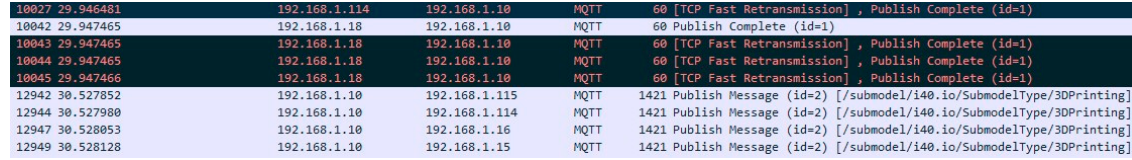
Figure 14. The retransmission of unacknowledged messages and new calls for proposal.